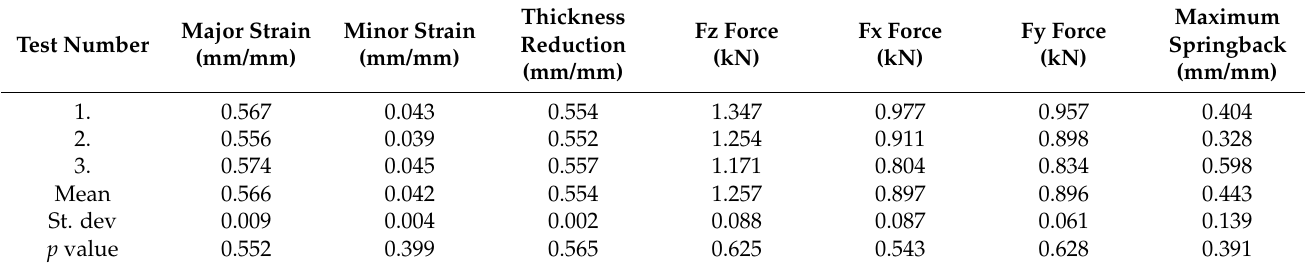
Table 7. Results for unwelded blanks processed by SPIF in truncated cone shape.